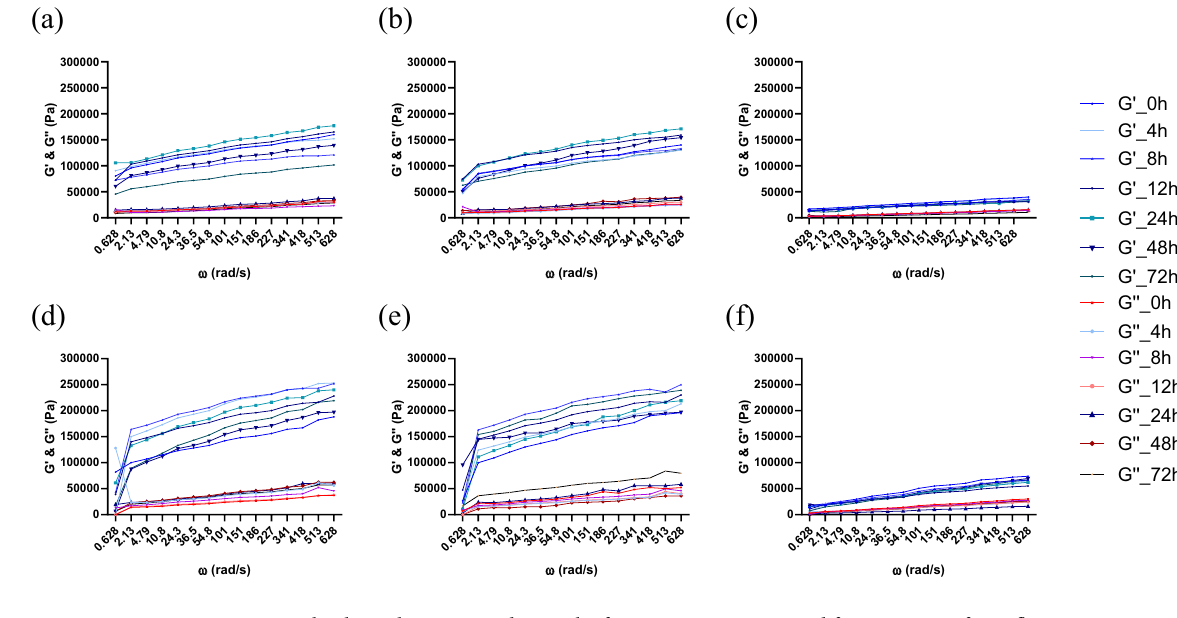
Figure 2. Rheological properties during the fermentation process and frozen storage for F. florum . Fermentation influence ( a ) SP10; ( b ) SP5; ( c ) SP0; and after frozen storage ( d ) SP10; ( e ) SP5; ( f ) SP0 (SP0—0% soy powder, SP5—5% soy powder, SP10—10% soy powder).